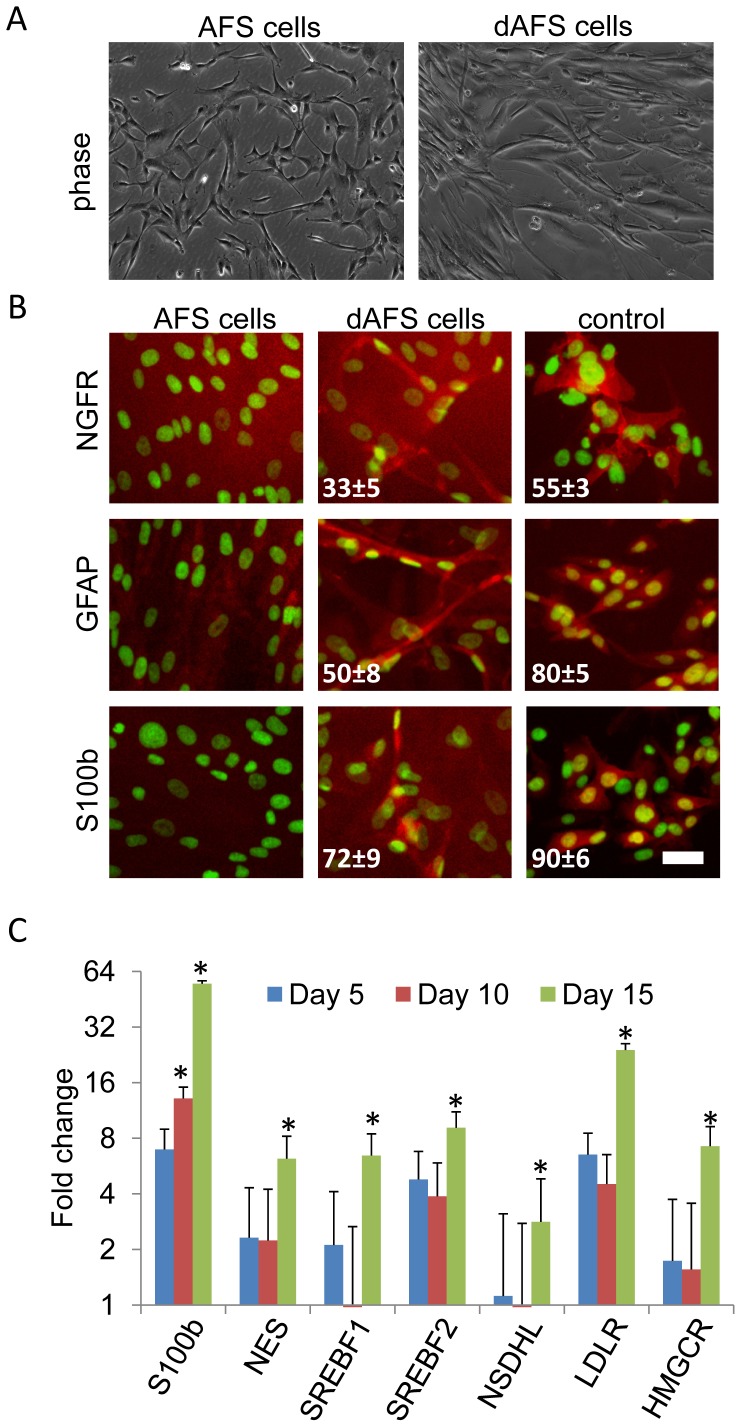
Human monoclonal amniotic fluid stem cells can be differentiated into a early Schwann cell phenotype.(A) AFS cells are small cells with omnidirectional protruding filopodia and upon differentiation to Schwann-like cells, at day 15 of treatment, cells exhibited an increase in cellular volume and an elongated cell morphology. Scale bar represents 50 µm. (B) Immunofluorescence staining of AFS cells differentiated for 15 days (dAFS) compared to undifferentiated AFS cells (AFS) and MCM1 neural crest-derived cells (control), for the Schwann cell markers NGFR, GFAP and S100b (labeled in red, nuclei labeled in green). Purity of cells is indicated as percent positive cells versus total amount of cells ± S.D. Scale bar represents 10 µm. (C) Quantitative RT-PCR of cDNA derived from AFS cells and from AFS cells subjected to Schwann cell differentiation after different time points was performed. Results are shown as fold change expression of respective genes compared to undifferentiated AFS cells. The results are expressed as means ± SEM of three independent experiments. P<0.05 for * vs undifferentiated AFS cells.